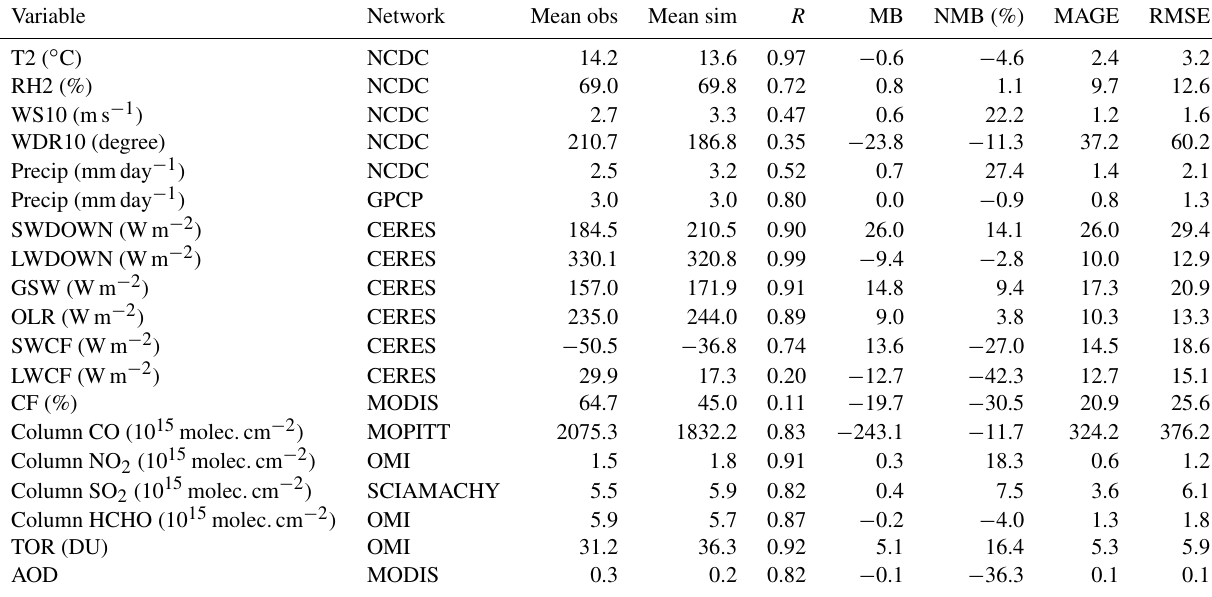
Table 3. Model performance statistics for the climatological application (2006–2010, CESM_BASE).